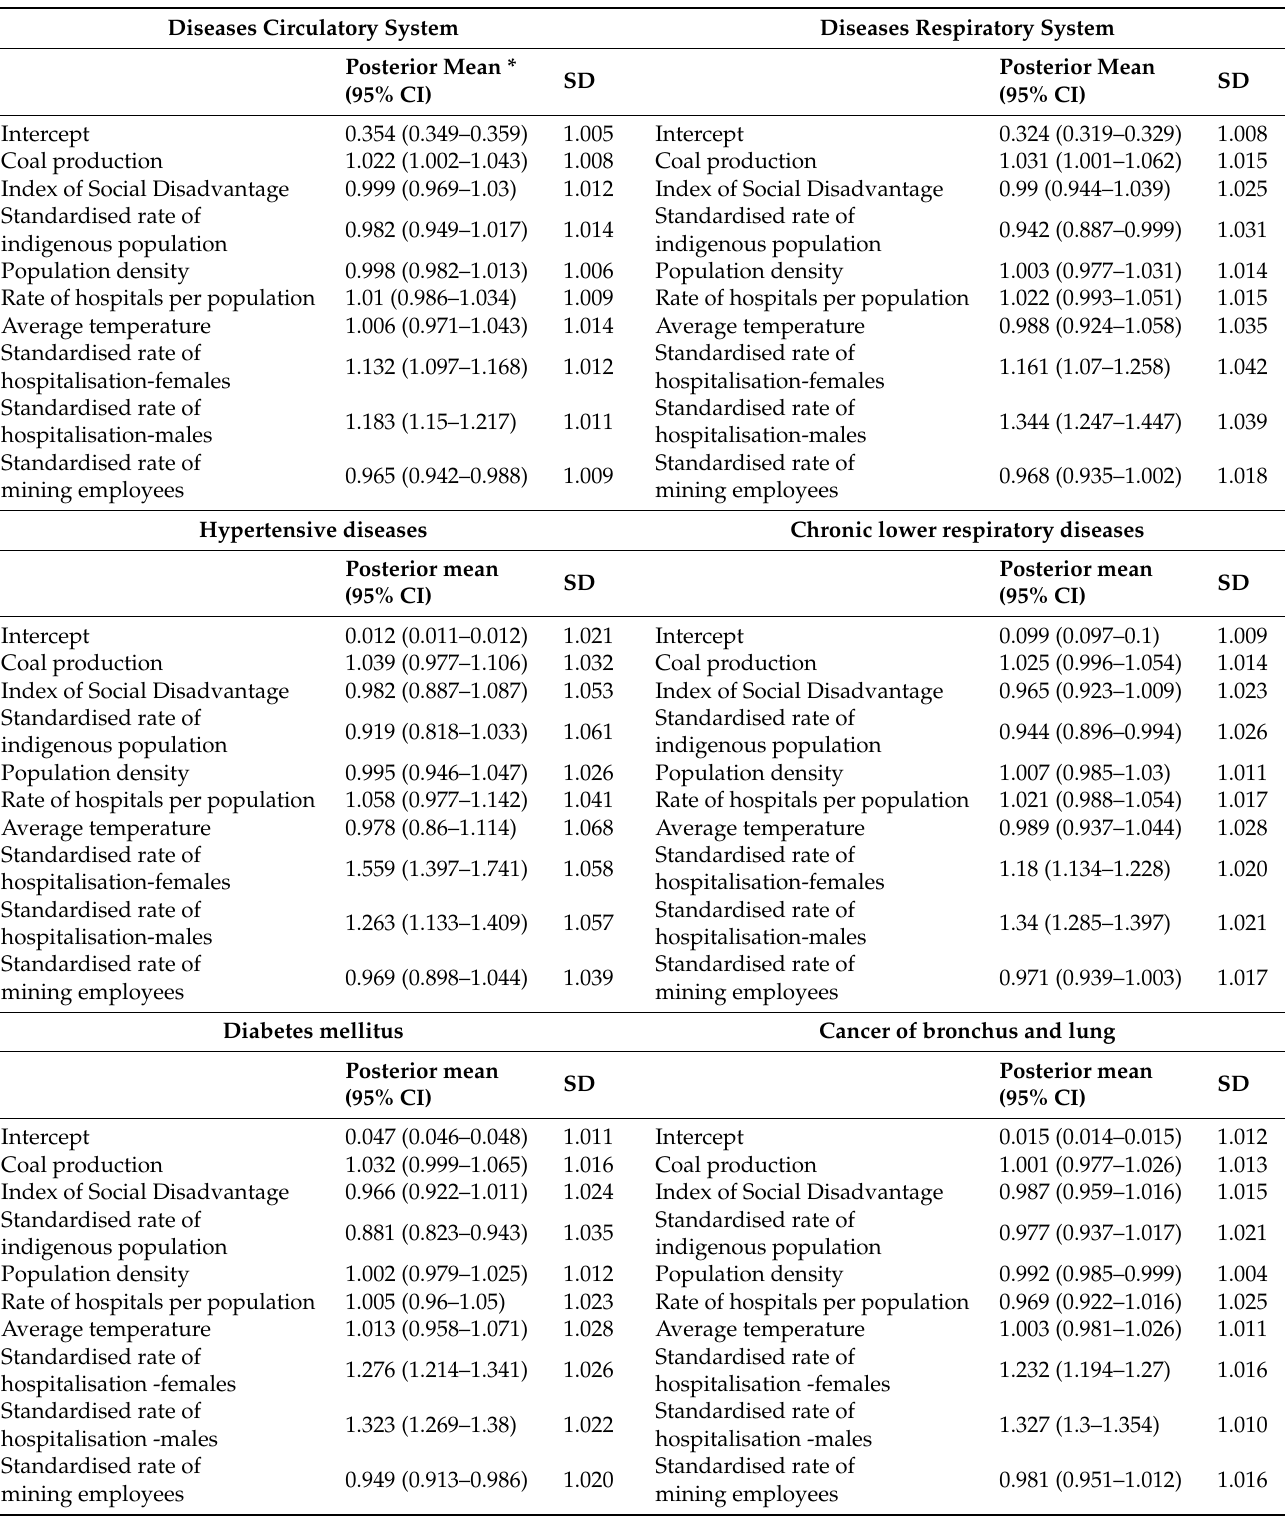
Table 3. Regression coefficients in the ecological model for each disease